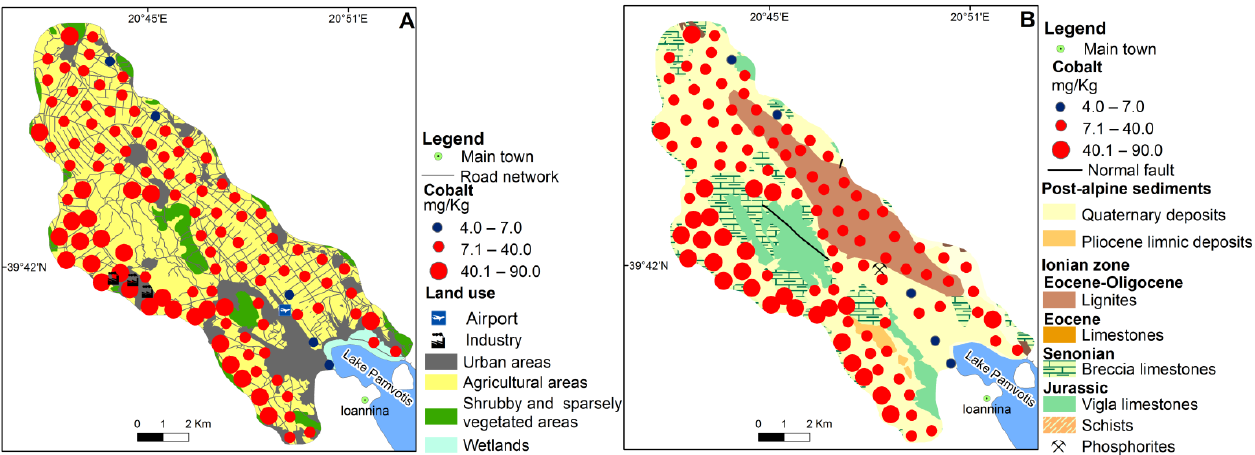
Figure 6. Graduated symbol plots of Co content in soil of Ioannina plain concerning land uses ( A ) and geology ( B ).